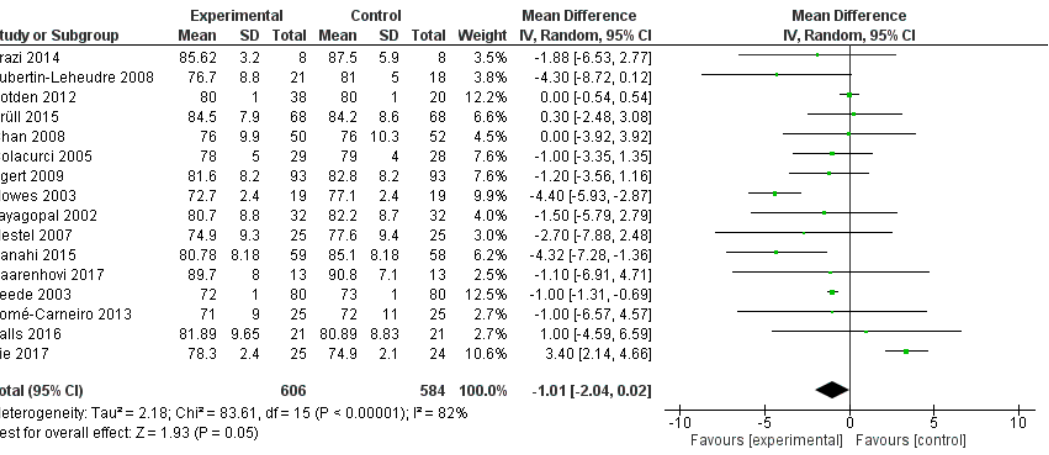
Figure 2. Pooled analysis of association between polyphenol intake and systolic blood pressure (SBP). The green square represents the mean difference detected in each study. The black diamond shows the final overall mean difference.